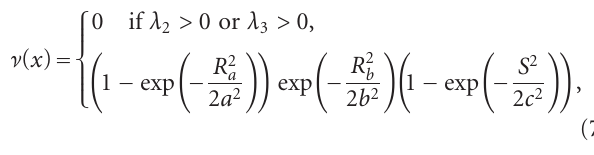
Figure 7: Mean Square Error (MSE) and Peak Signal-to-Noise Ratio (PSNR) measurements for manual image